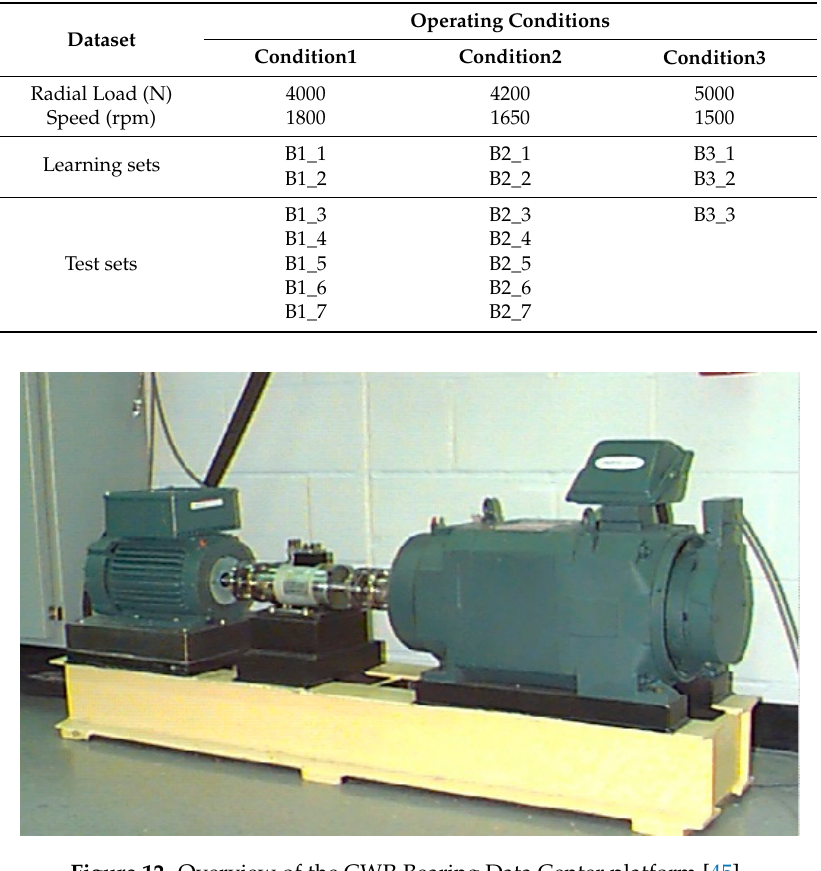
Figure 11. Overview of the PRONOSTIA platform [43]. Table 1. PRONOSTIA datasets versus operating conditions specifications [43].